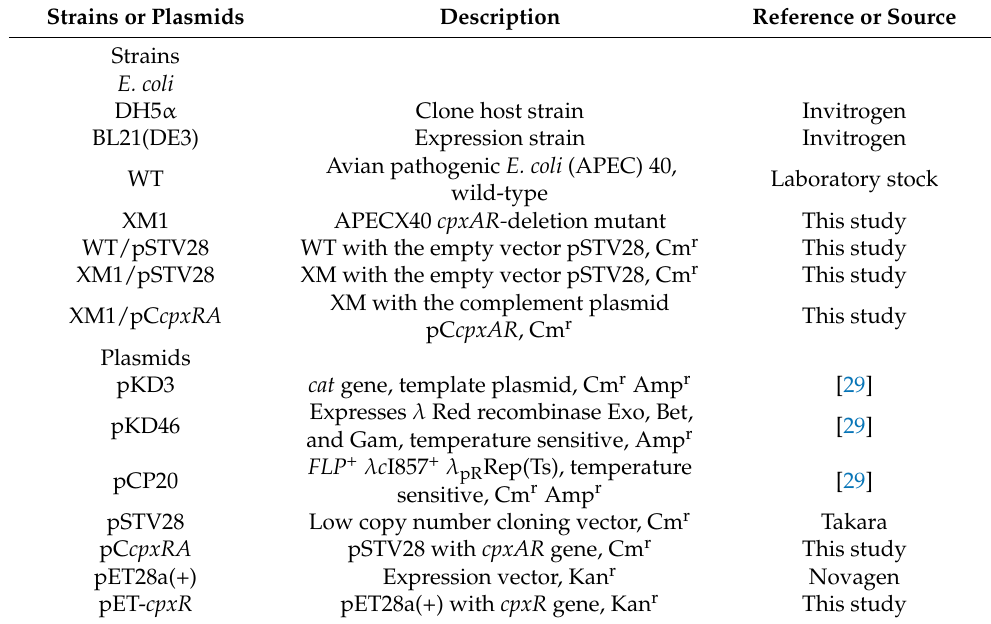
Table 1. Strains and plasmids used in this